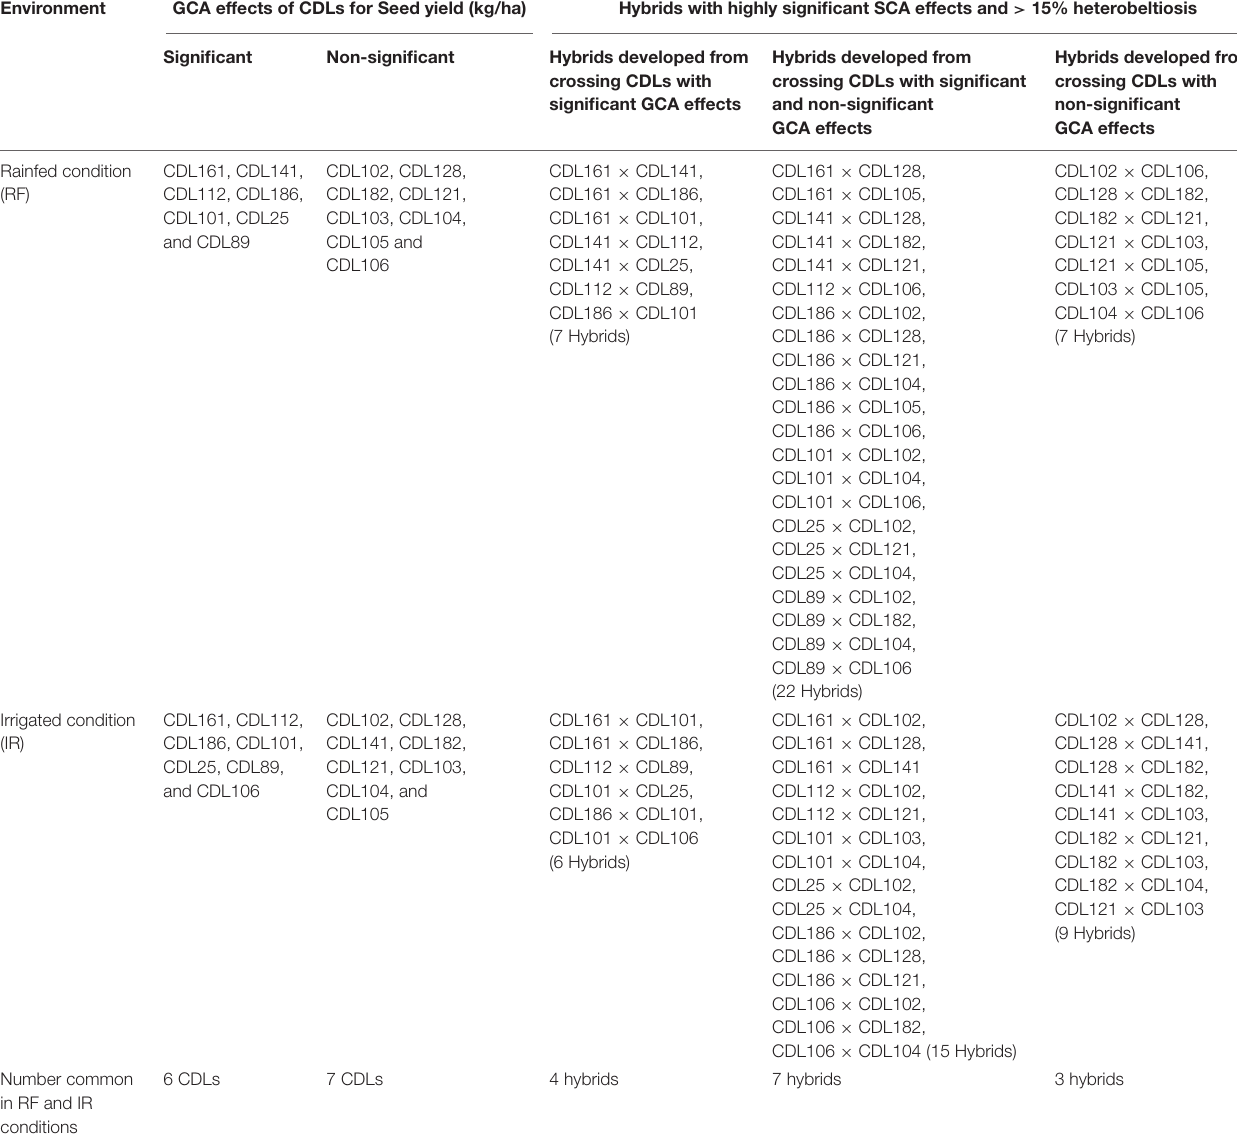
TABLE 6 | Combining ability and heterobeltiosis of hybrids derived from CDLs with different levels of GCA effects for seed yield (kg/ha) under irrigated and rainfed